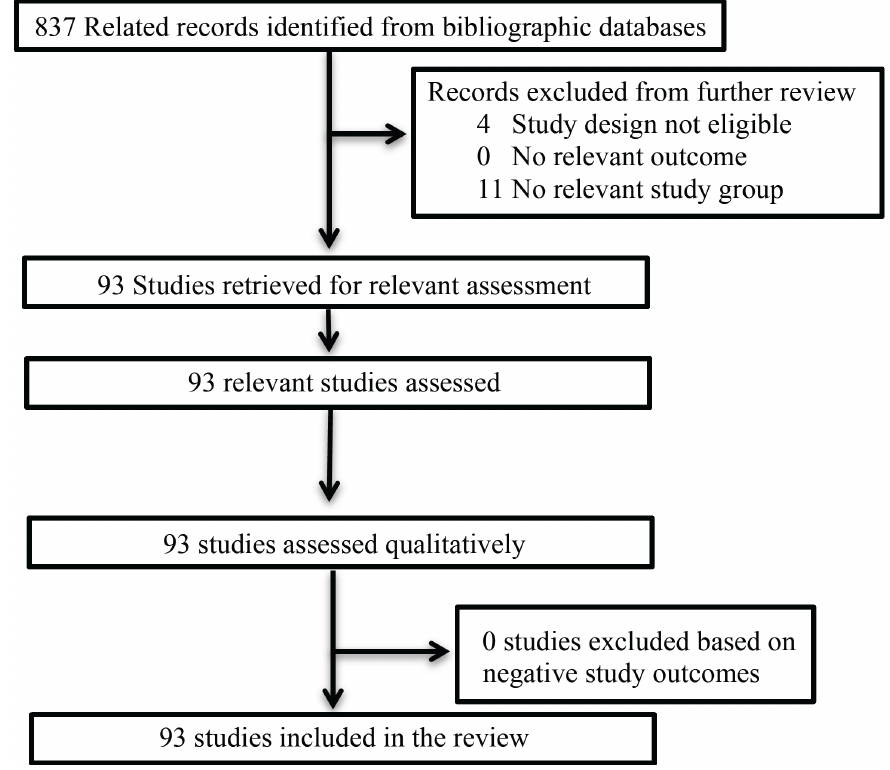
Figure 1. Flow diagram of studies for limited